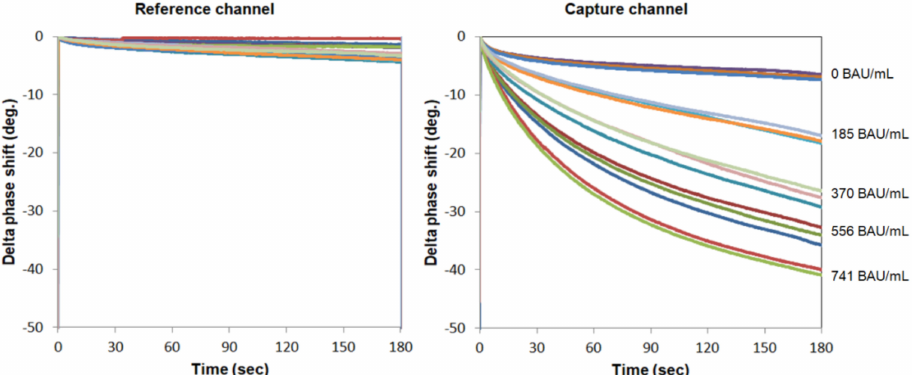
Figure 3. Real-time measurement of various concentrations of total anti-S protein antibodies in the reference and capture channels.